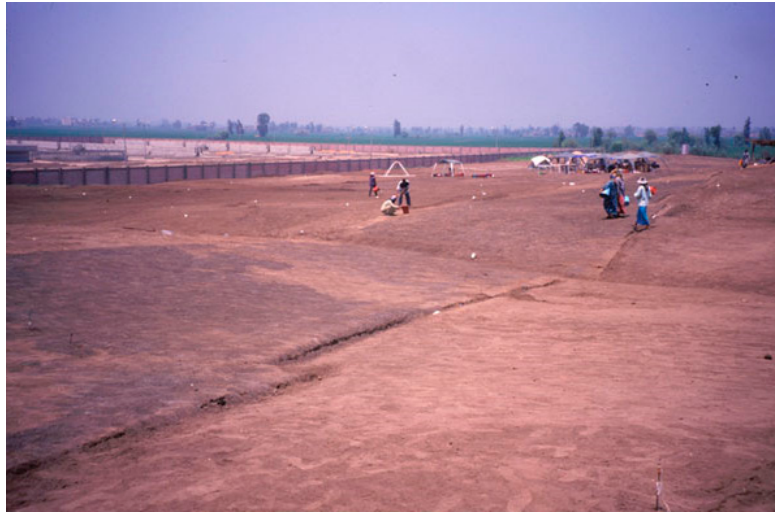
Figure 3. Excavating the eastern side of the mudbrick enclosure wall, 2003 Tell Tebilla project. The modern water plant is in the background. Imagery courtesy of S. Parcak.